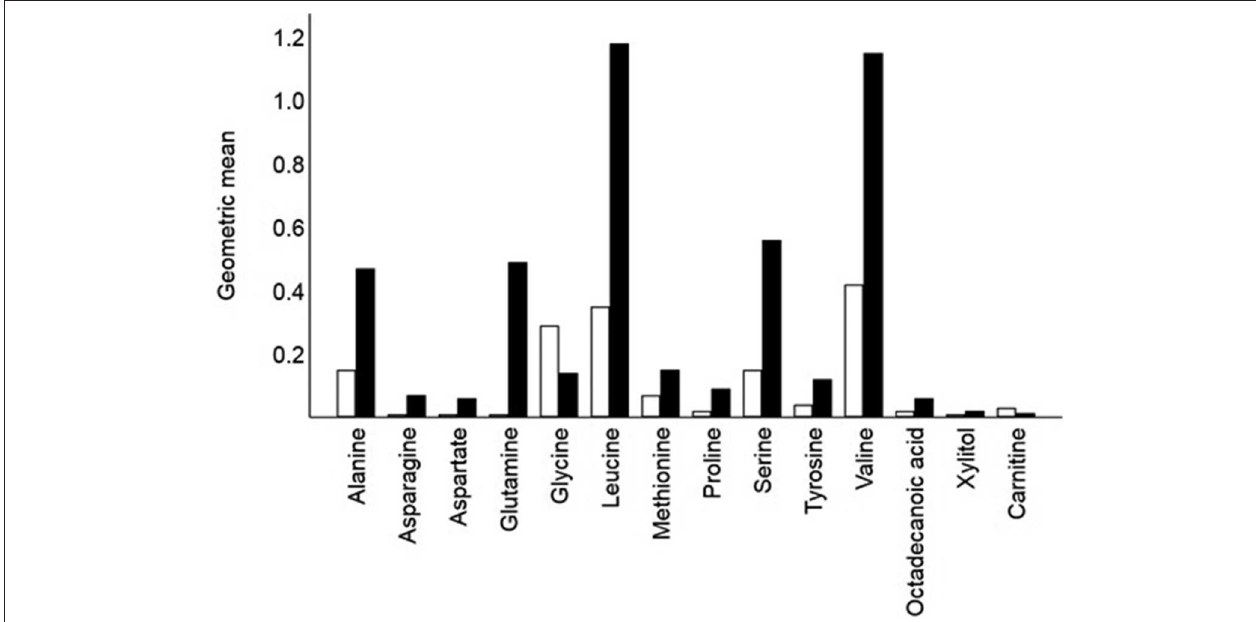
FIGURE 2 | Crude geometric means for 14 of the 16 metabolites that differed signified between remission cats (hollow bars; n = 20) and control cats (solid bar n = 22). Glucose (means 42.9 and 33.3, respectively) and urea (means 4.1 and 2.5, respectively) also differed significantly between remission and control cats. Each bar shows the mean of the relative response ratios for each